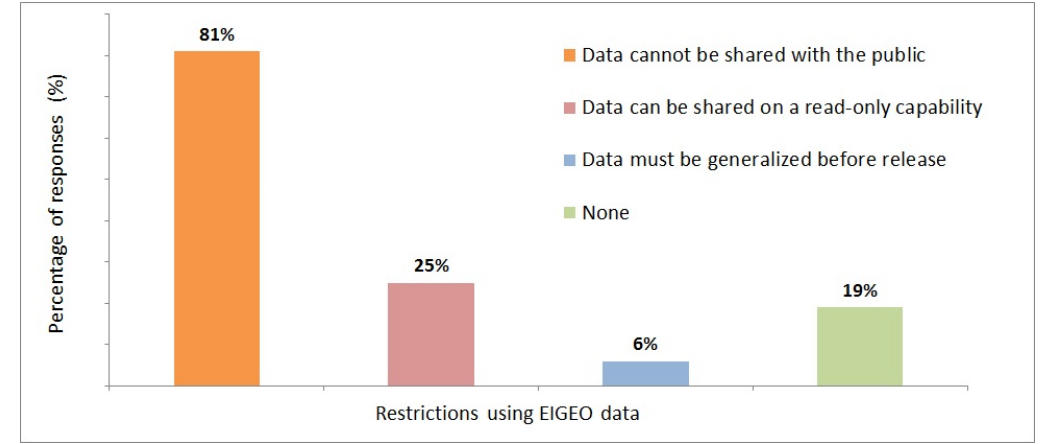
Figure 8 . Restrictions for using EIGEO data (Q21). Note: Multiple answers allowed . Figure 8. Restrictions for using EIGEO data (Q21). Note: Multiple answers